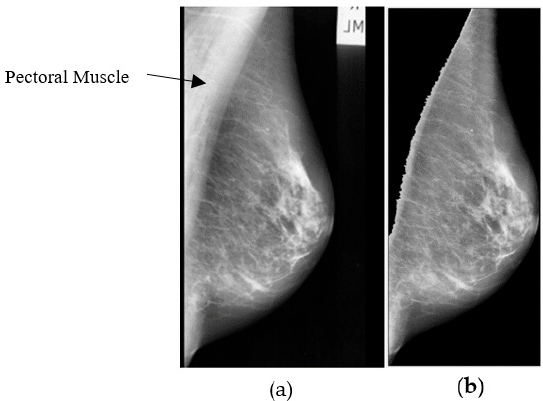
Figure 4. ( a ) Original enhanced abnormal mass case extracted from MIAS dataset [13] and ( b ) Pectoral muscle removal.